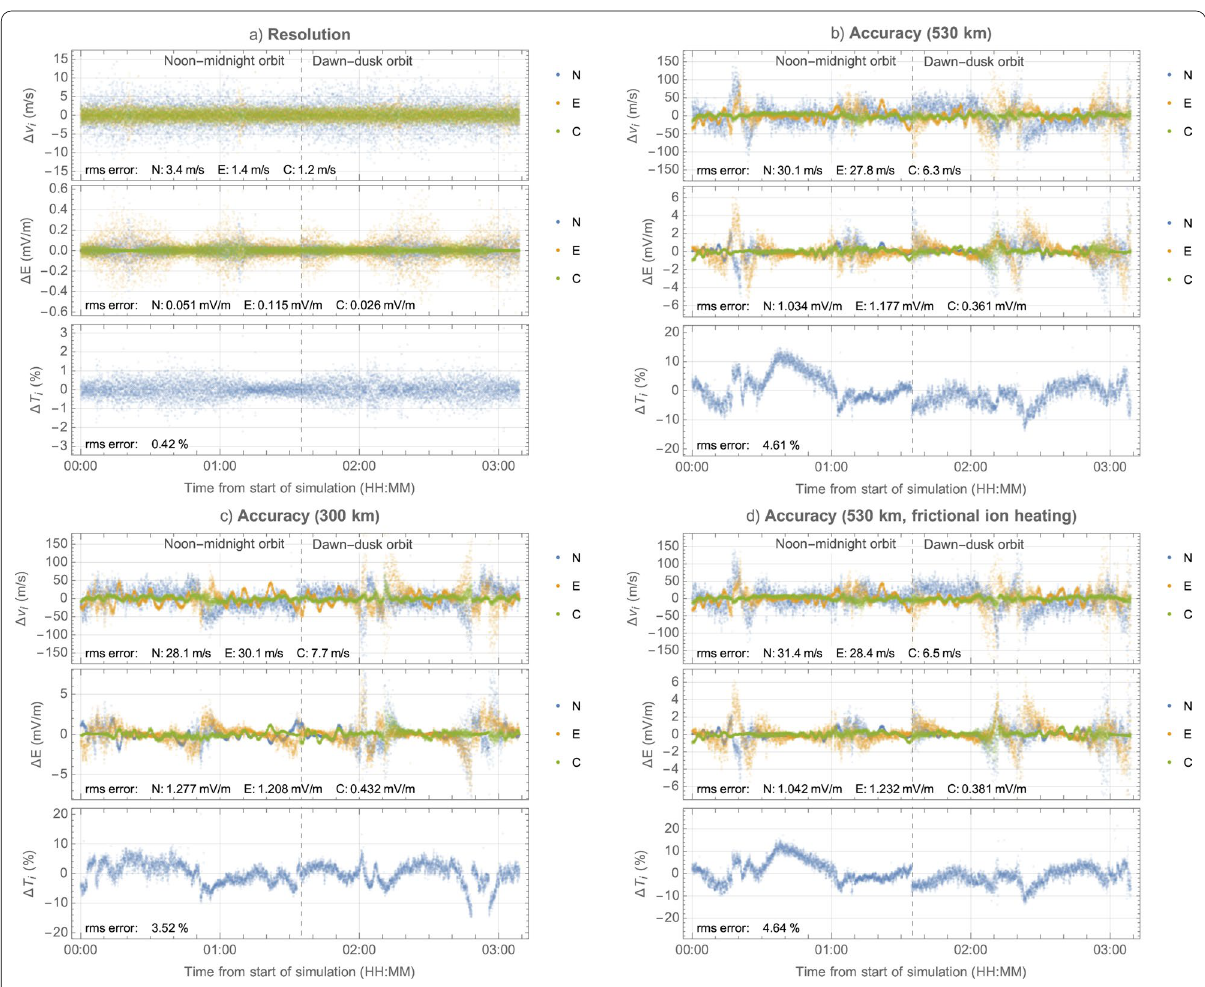
Fig. 28 Time series for total measurement error estimated using the EES, plotted in the same format as Fig. 26: a resolution; b accuracy at 530 km altitude; c accuracy at 300 km altitude; d accuracy at 530 km altitude with ion frictional heating at high